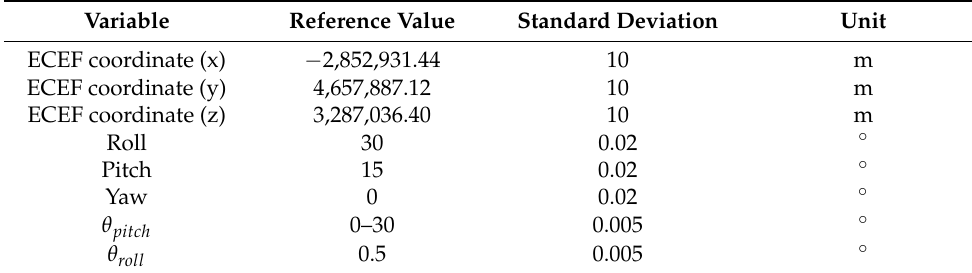
Table 1. Simulation parameters of aerial remote sensing images.